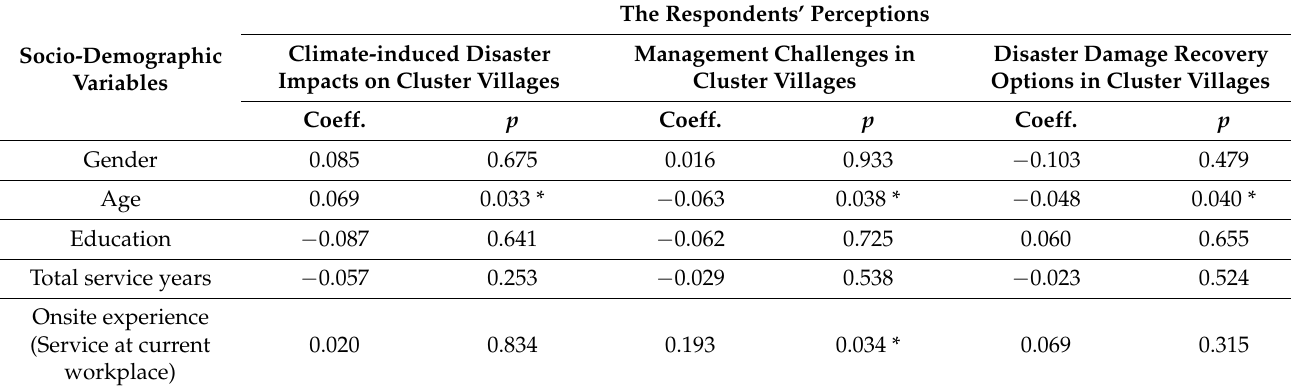
Table 3. Factors affecting the perception of the